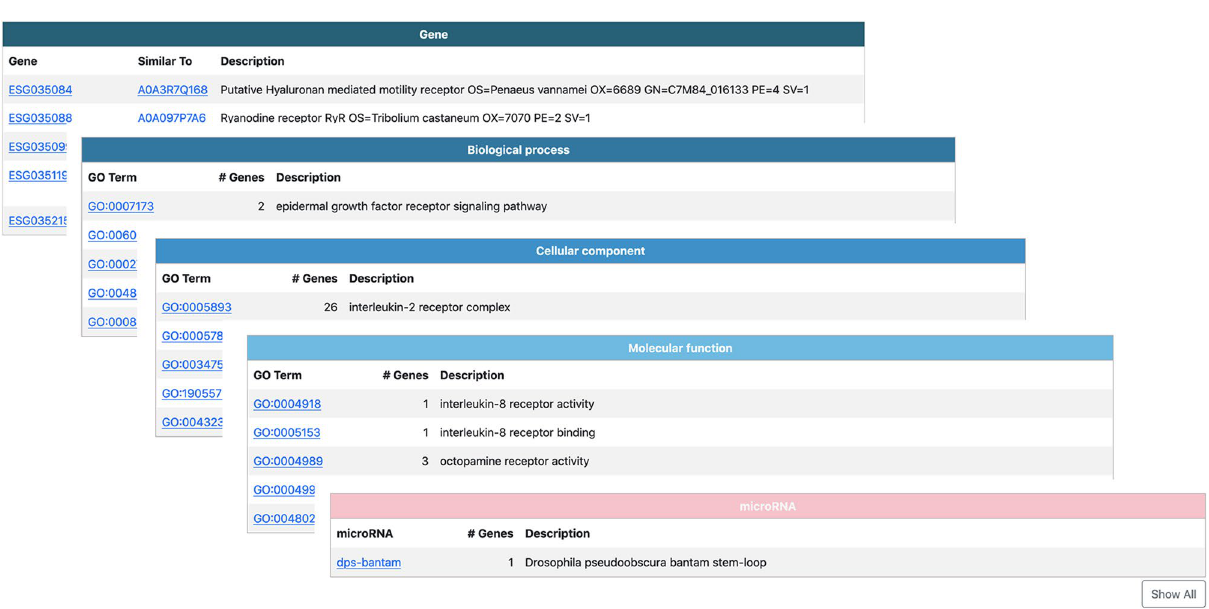
Figure 4. Differential Expression section. The new section collecting all differentially expressed genes tables ( a ) with an example of the corresponding result for a selected contrast ( b ).